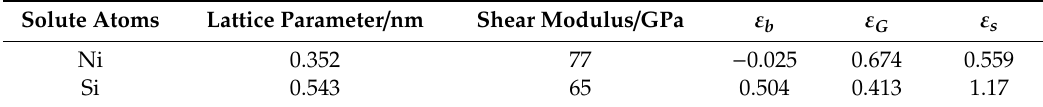
Table 7. Relevant parameters of solid solution atoms in alloys.